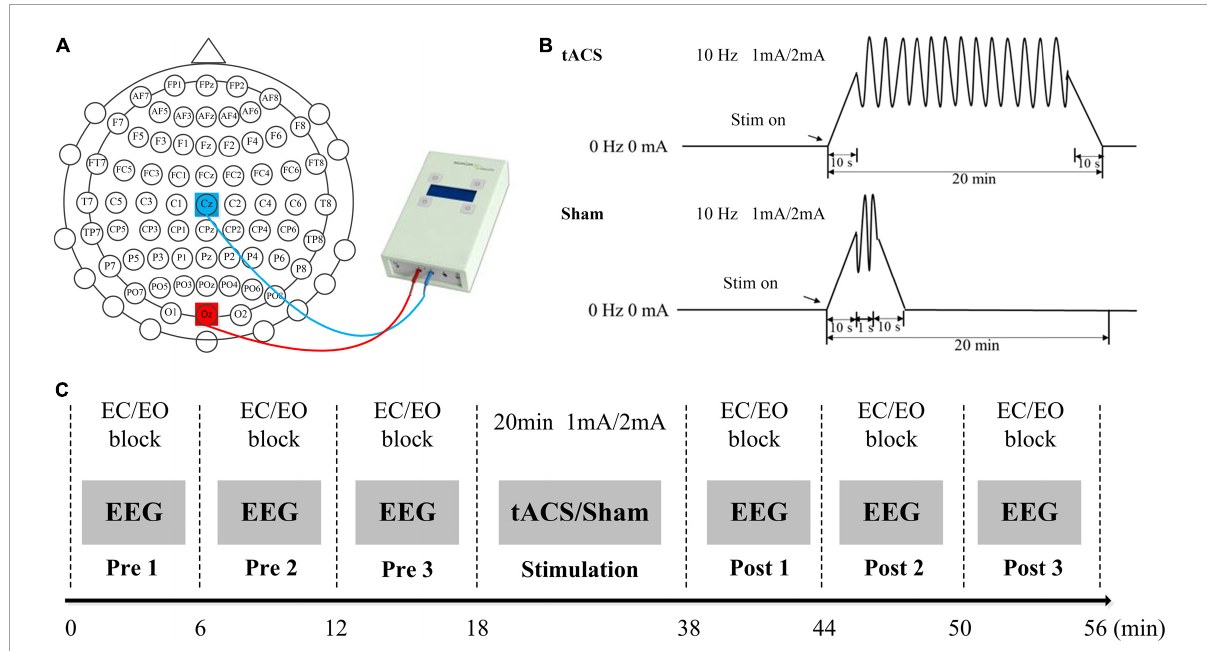
FIGURE1 Experimental design. (A) The positions of the stimulating electrodes. (B) Experimental stimulation. (C) Experimental paradigm. EO, during the eyes-open state; EC, during the eyes-closed